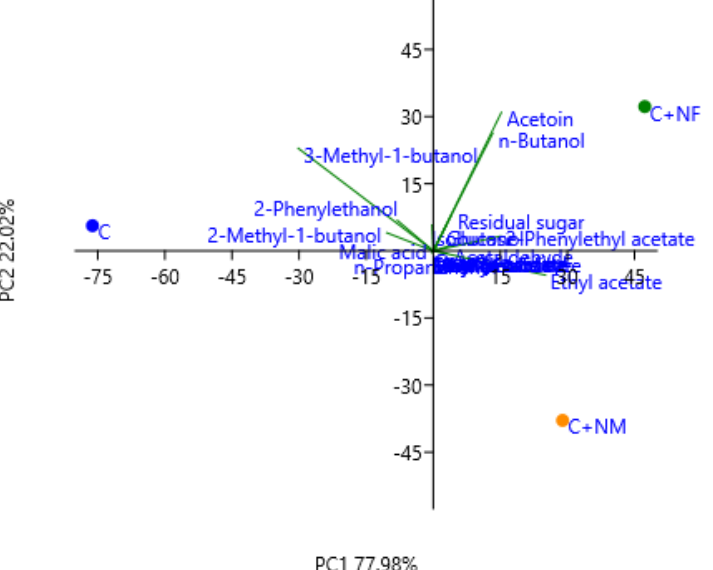
Figure 5. Principal component analysis (PCA) biplot of volatile compounds and main oenological parameters, determined in wines obtained by the mixed starters with S. cerevisiae EC1118 (C) and H. osmophila ND1 in two different formulations (NF—free cells; NM—microencapsulated cells) in comparison to single starter wine with EC1118 (C).